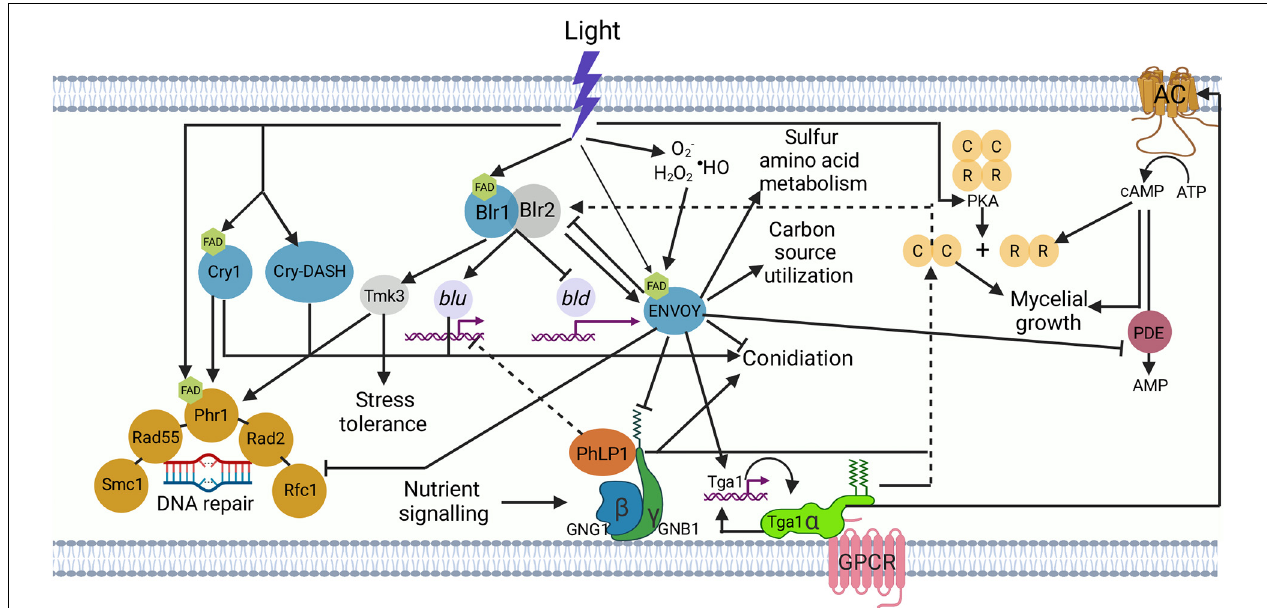
FIGURE 7 | Trichoderma atroviride light signal perception and transduction. The BLR-1 and BLR-2 proteins sense blue light through the chromophore attached to the BLR-1 protein, a flavin adenine dinucleotide molecule (FAD; pentagon; Casas-Flores et al., 2004). The activated BLR complex binds to the promoters of target genes, leading to the activation of blue light up-regulated ( blu ) or repression of blue light down-regulated ( bld ) genes. The increase in the proteins encoded by the blu genes leads to stress tolerance, DNA repair, conidiation, and the synthesis of proteins of secondary photoreceptors, including CRY1, CRY-DASH, and ENVOY. Once ENVOY perceives light, presumably through FAD (Schmoll et al., 2005), it modulates blu and bld gene expression by putatively inactivating the BLR complex, resulting in the activation of carbon source utilization and sulfur metabolism genes, promotion of mycelial growth, and repression of DNA repair genes and conidiation. Besides its activation by light ENVOY perceives reactive oxygen species (H 2 O 2 , O 2 • − and • HO) provoked by the interaction of light with biological molecules such as flavins and porphyrins, or by nutrient deprivation (Lokhandwala et al., 2015). Light stimulates protein kinase A (PKA) activity (Casas-Flores et al., 2006). ENVOY represses the activity of the phosphodiesterase (PDE); an enzyme that degrades cAMP accumulated owing to the activation of TGA1, which activates adenylyl cyclase (AC), allowing the synthesis of cAMP (cyclic adenosine monophosphate). Accumulation of cAMP leads to the release of the catalytic subunit (C) of protein kinase A (PKA) due to binding of cAMP to the regulatory subunit (R), to positively regulate conidiation and mycelial growth. PKA could also positively regulate the BLR complex (dashed lines from PKA to BLR complex). The accumulation of cAMP has a positive effect on mycelial growth. ENVOY negatively regulates the putative interaction of the phosducin-like (PhPL chaperone) product with the GNB1/GNG1 heterodimer to dissociate the active complex that positively regulates conidiation (Tisch et al., 2014). Nutrient signaling has a positive effect on the PhPL/GNB1/GNG1 complex (Tisch et al., 2014). The PhPL/GNB1/GNG1 complex exerts a negative regulation on blu genes. In the inactive state, the three G-protein subunits ( α , β , γ ) are present in a complex, in association with G-protein-coupled receptors (GPCRs). Ligand binding to the GPCR leads to dissociation of the G α subunit from the G βγ dimer. Solid arrows represent positive regulation, whereas dotted arrows show a presumably positive regulation. Lines with a bar at the end indicate negative